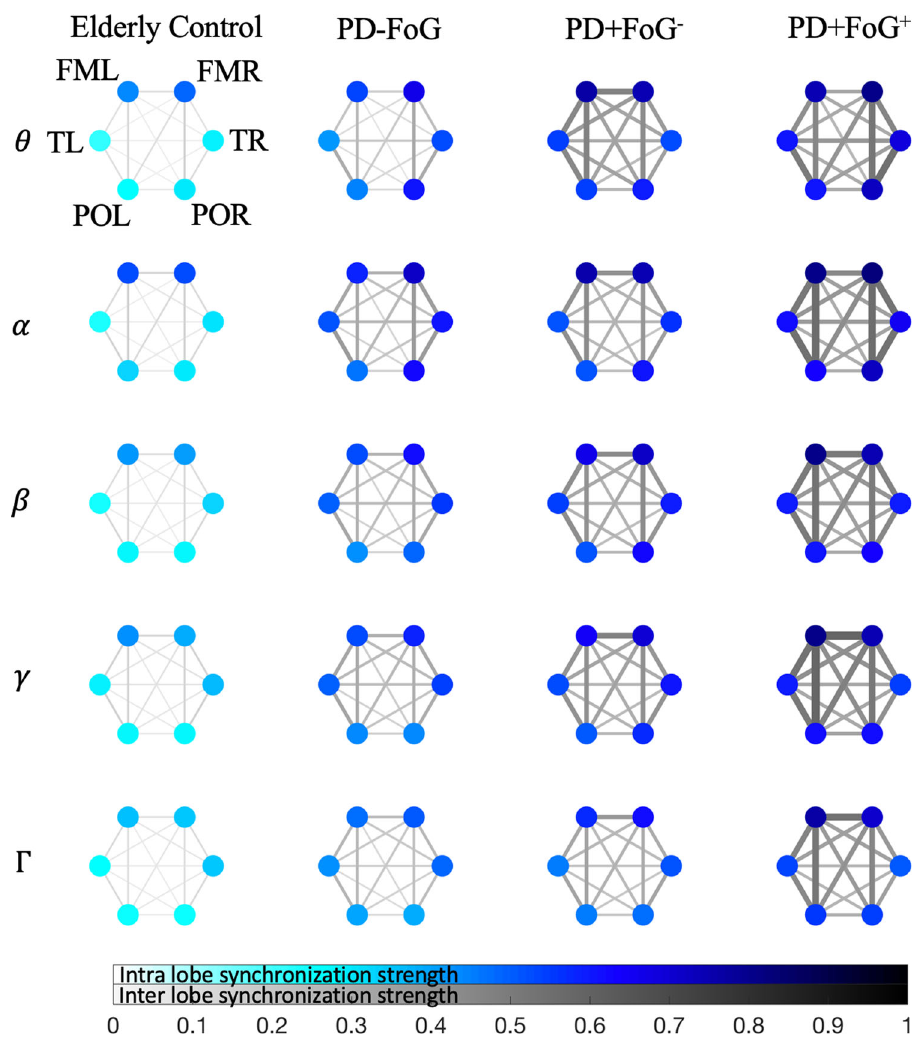
Fig. 3 Physiological networks of brain lobe interactions for different EEG frequency bands. The brain lobe interaction matrices R × χ are used to construct physiological networks for each frequency band and for each group during normal walking (cp. Fig. 2c for α − α interactions for all four groups). Network nodes correspond to the six brain lobes and the color-coding of the nodes is according to the intra-lobe interaction values obtained from the diagonal matrix elements of the lobe-averaged R × χ matrices. Weighted network links re fl ect inter-lobe interaction as given by the value of the non- diagonal matrix elements, and darker gray color and thicker lines represent stronger interactions. Subjects with Parkinson ’ s disease (PD) generally exhibit higher levels of brain lobe interactions, and the highest values are observed for PD + FoG + consistently across all EEG frequency